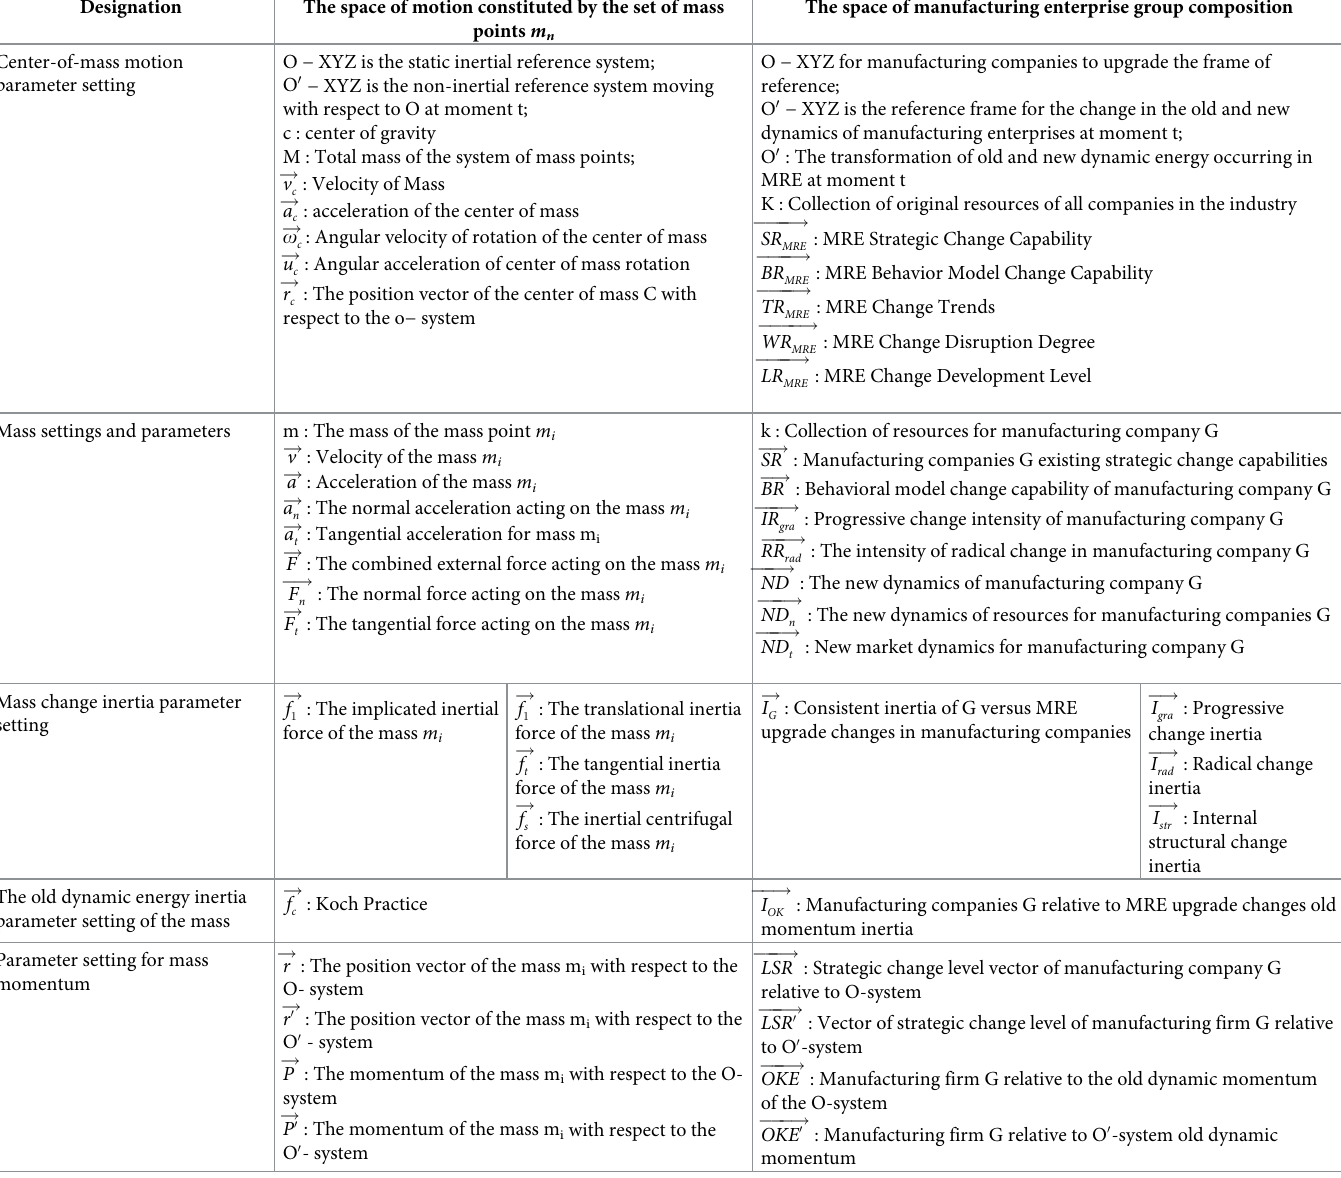
Table 1. Cross-relationship between green transformation of manufacturing industry and kinetic theory. Designation